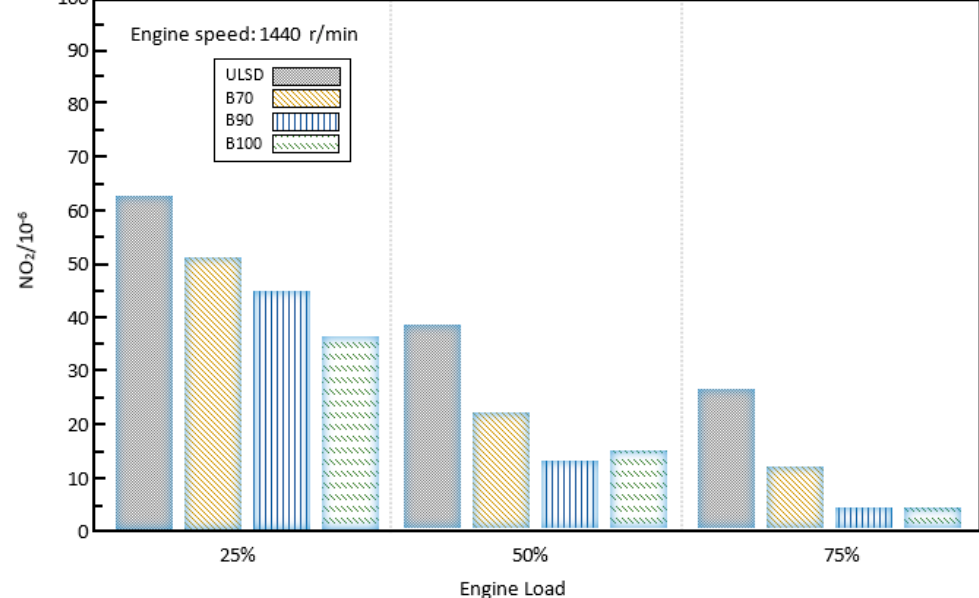
Figure 13. Tested fuels’ influence on the exhaust gas temperature at 1200 rpm .